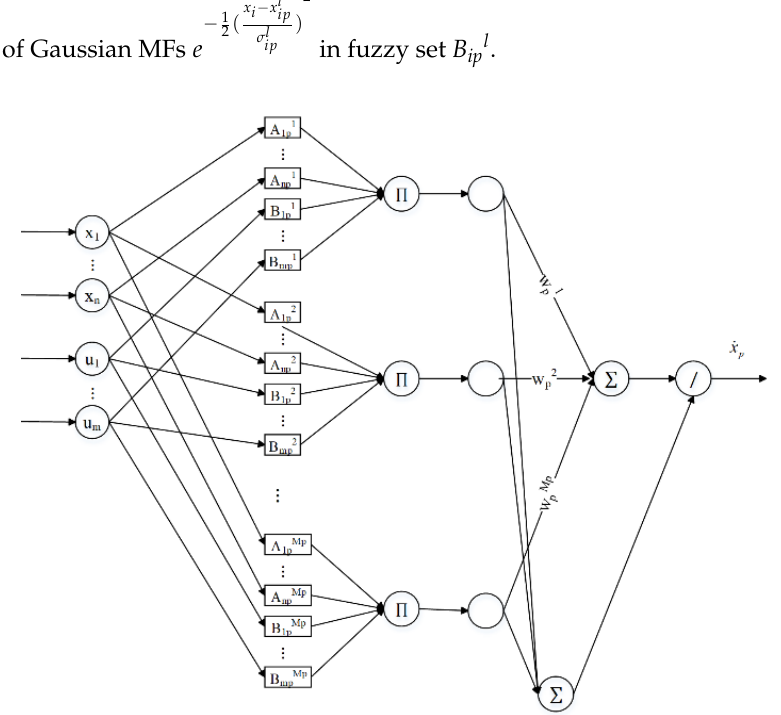
Figure 1. Structure of the FBFN.